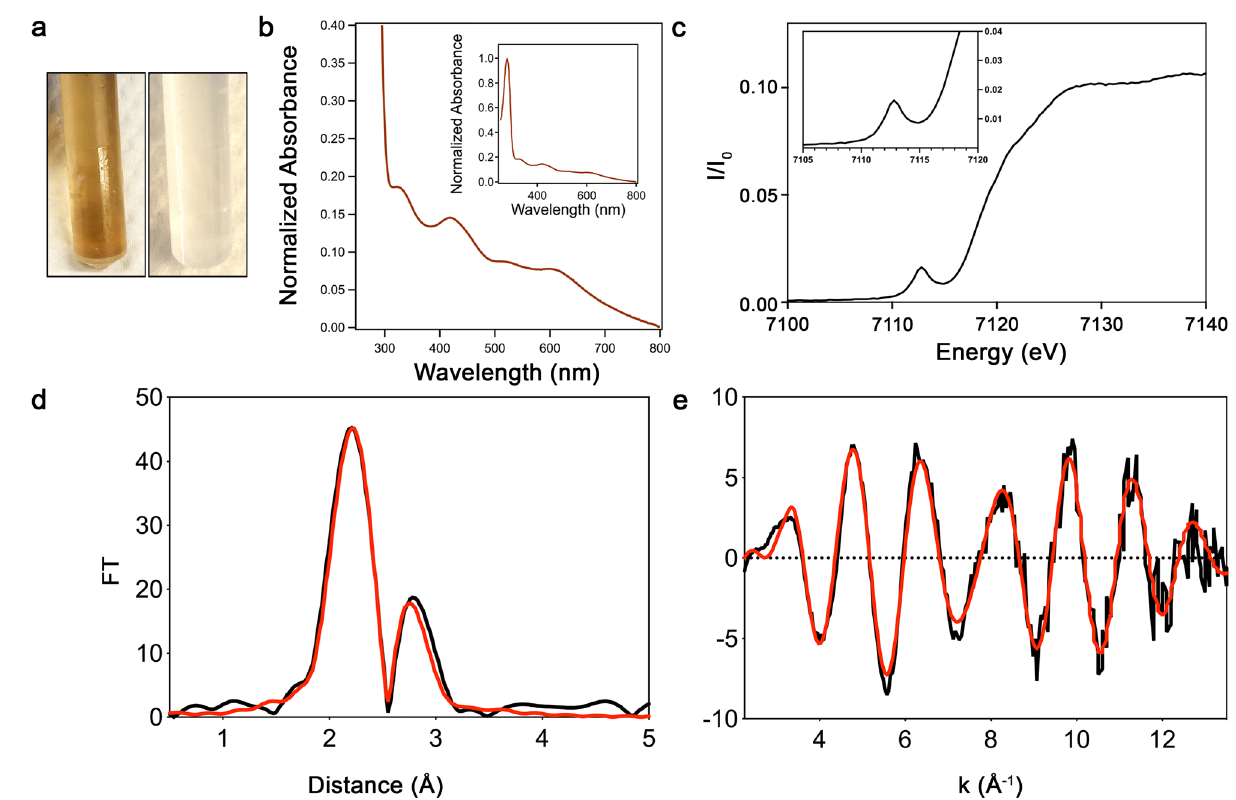
Fig. 2 | Sc ATE1 binds a [2Fe-2S] 2+ cluster when puri fi ed under oxic conditions. a Photographs of plastic tubes containing puri fi ed Sc ATE1 (brown, left) and buffer (colorless, right) suggest the presenceofan[Fe-S]cluster. b Features of the visible electronic absorption spectrum of Sc ATE1 isolated under oxic conditions indicate the presenceofa [2Fe-2S] 2+ cluster. Inset: expanded absorption spectrum showing both UV and visible regions. c The Fe XANES of Sc ATE1 isolated under oxic